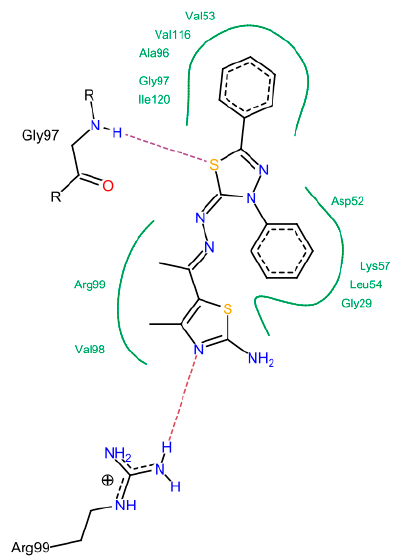
Figure 8. The possible binding mode of compound 11.